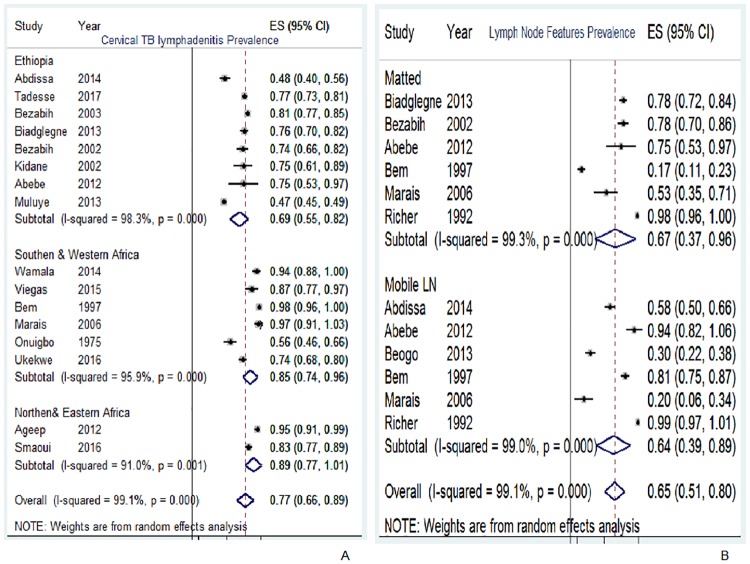
Pooled prevalence of TBLN types and features, Africa, 1970–2015.